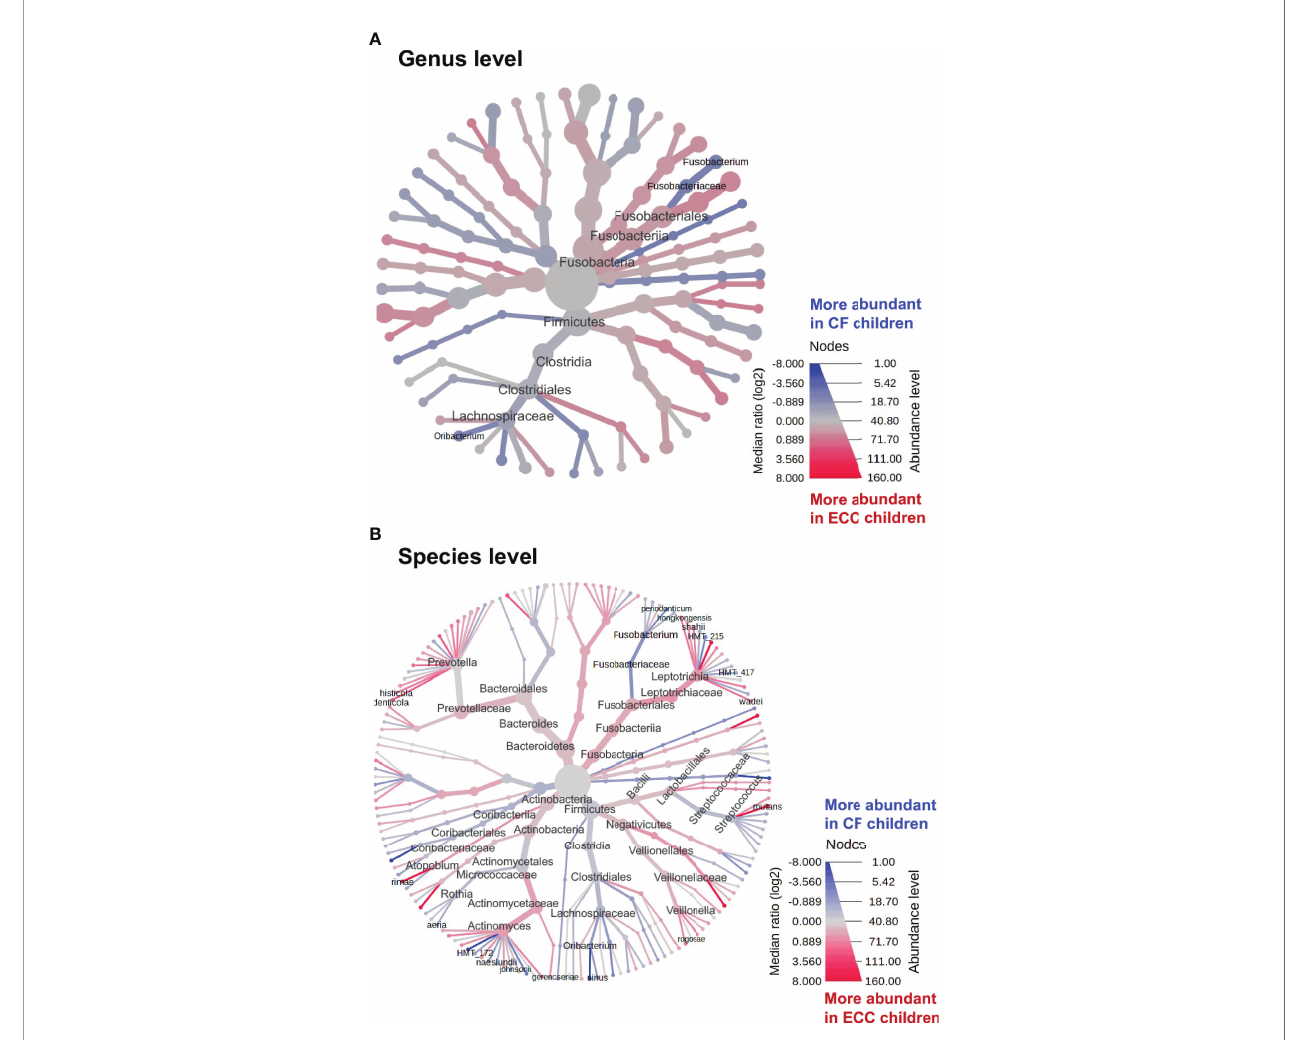
FIGURE 4 | Heat trees of salivary microbiome abundance among ECC and caries-free children. The heat trees depict the OTU classi fi cations and differential abundance comparison at the genus level (A) and at the species level (B) between salivary microbiome of children with ECC and without ECC. In the heat trees, size and color of nodes and edges are correlated with the abundance ratio of organisms in ECC children vs. caries-free children. Taxa colored in red are enriched in ECC Children, whereas taxa colored in blue are enriched in caries-free children. Taxa with labels indicate a signi fi cant abundance difference between ECC children vs. caries-free children measured by the Wilcoxon Rank Sum test